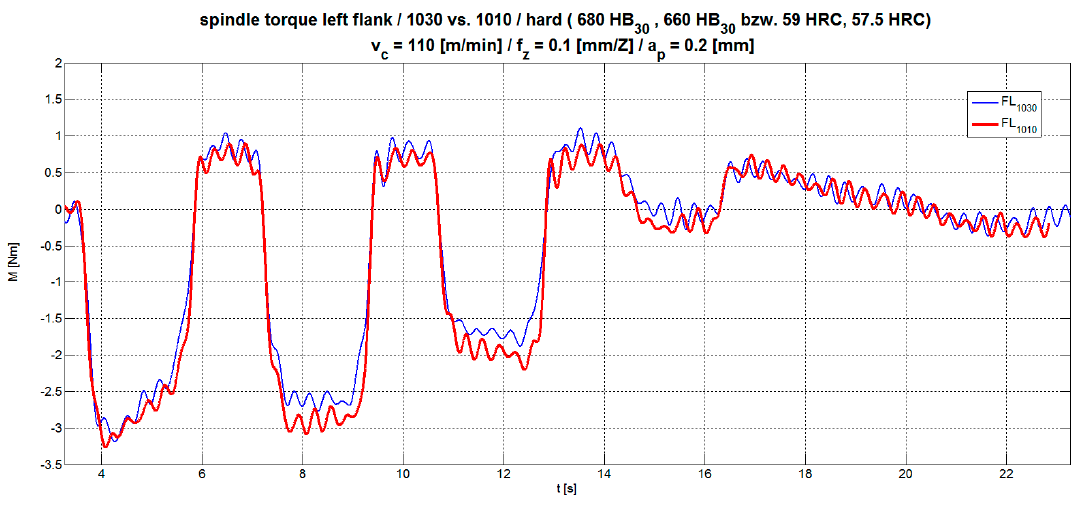
Figure 13. Course of spindle torque during finish operation on hard with standard inserts of type 1030 and special inserts of type 1010.